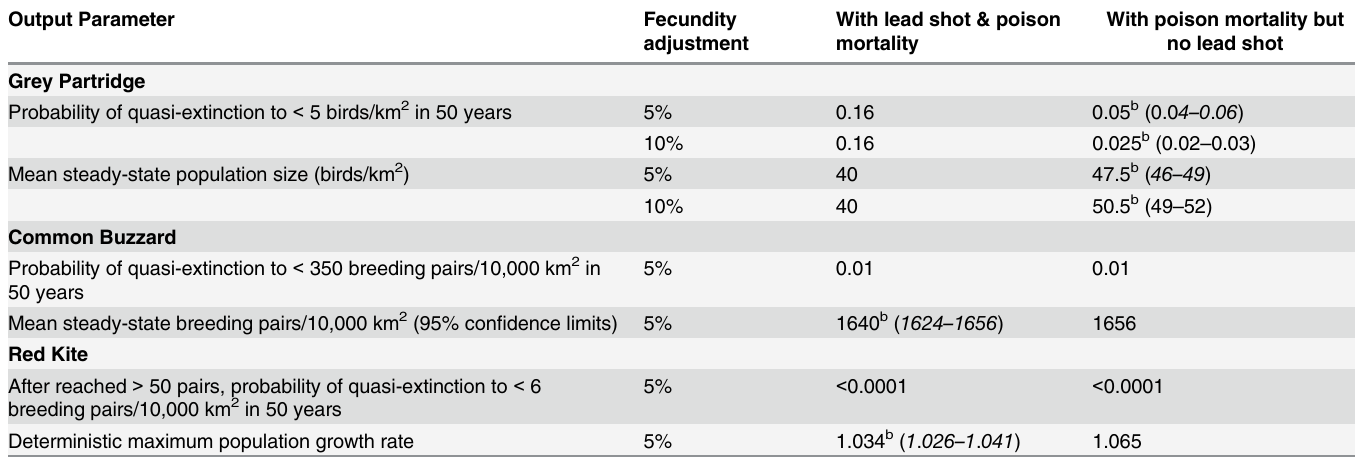
Table 3. Results of sensitivity analyses in which the non-baseline a scenario has fecundity further adjusted for impacts (by lead shot or poison) by 5 or 10% for the grey partridge and by 5% for raptors.